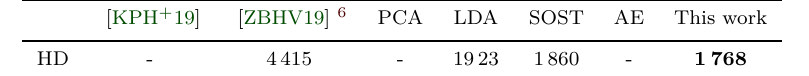
Table 5: Benchmark the attack performance ( T GE 0 ) with the AES_HD